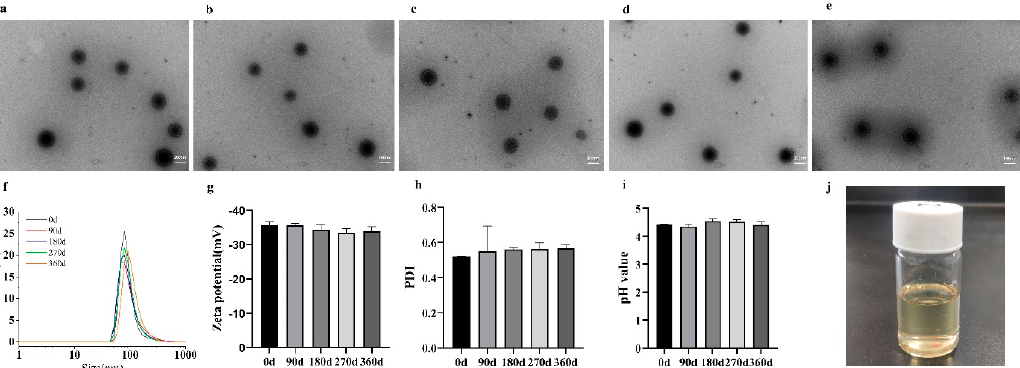
Figure 4. Stability testing of the SNA adjuvants. ( a ) SNA transmission electron micrograph of 0 days. ( b ) SNA transmission electron micrograph of 90 days. ( c ) SNA transmission electron micrograph of 180 days. ( d ) SNA transmission electron micrograph of 270 days. ( e ) SNA transmission electron micrograph of 360 days. ( f ) The particle size for different preservation periods. ( g ) The zeta potential for different preservation periods. ( h ) The PDI for different preservation periods. ( i ) The pH for different preservation periods. ( j ) The SNA after the high − speed centrifugal and thermodynamic stability